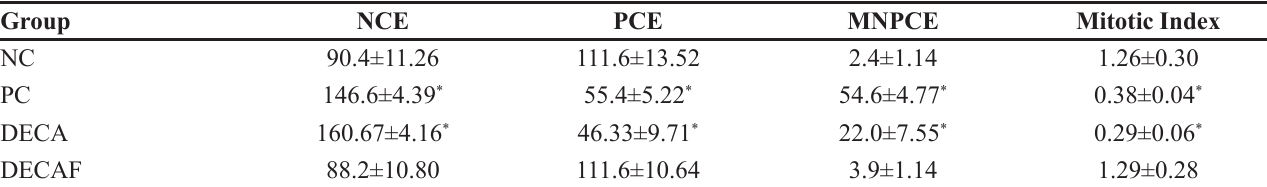
TABLE I - Number of normochromatic erythrocytes (NCE), micronucleated polychromatic erythrocytes (MNPCE) or not (PCE), and the mitotic index each group (relation PCE/NCE) in bone marrow of Wistar rats treated with DN. Result of the analysis